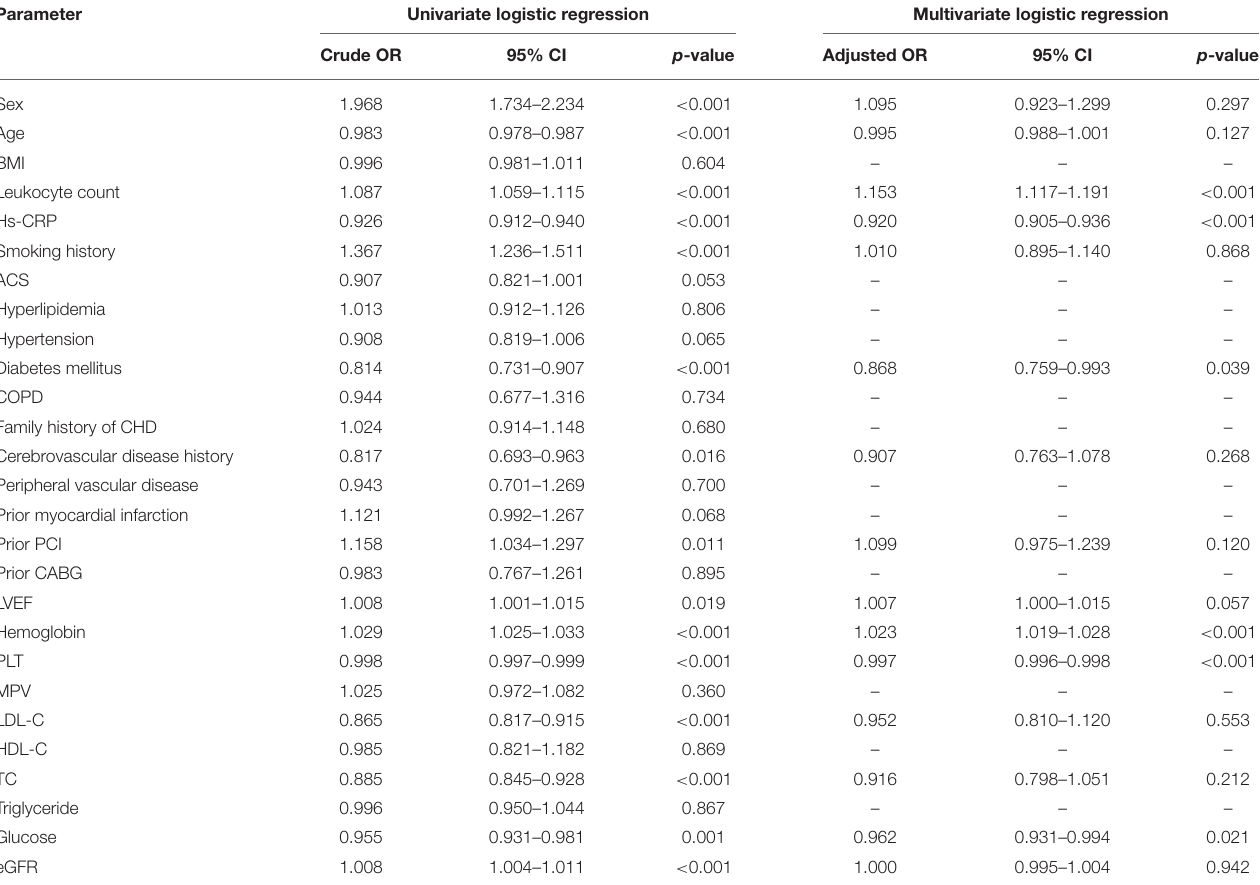
TABLE 2 | Logistic regression for